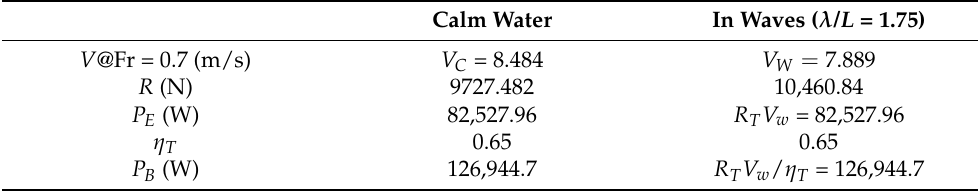
Table 10. Speed loss evaluation of the Double-M craft.